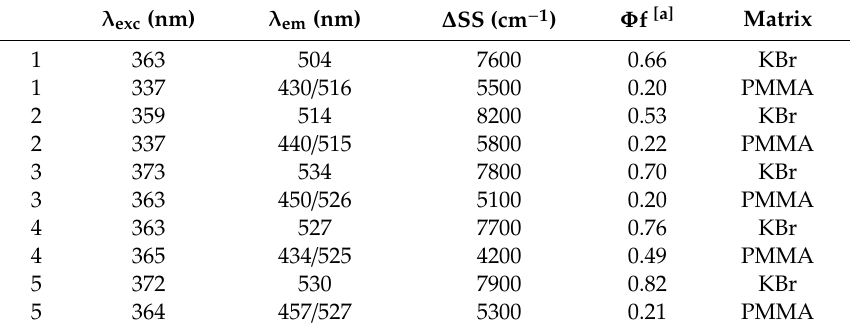
Table 2. Photophysical data of HBO dyes 1 – 5 measured the solid-state.